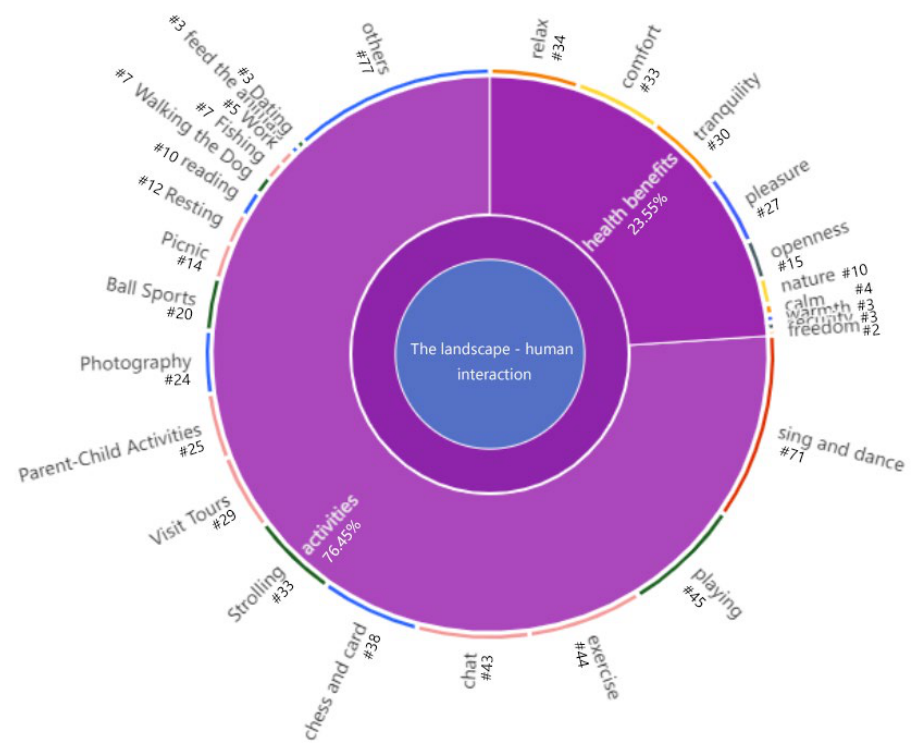
Figure 8. The landscape–human interaction coding diagram.